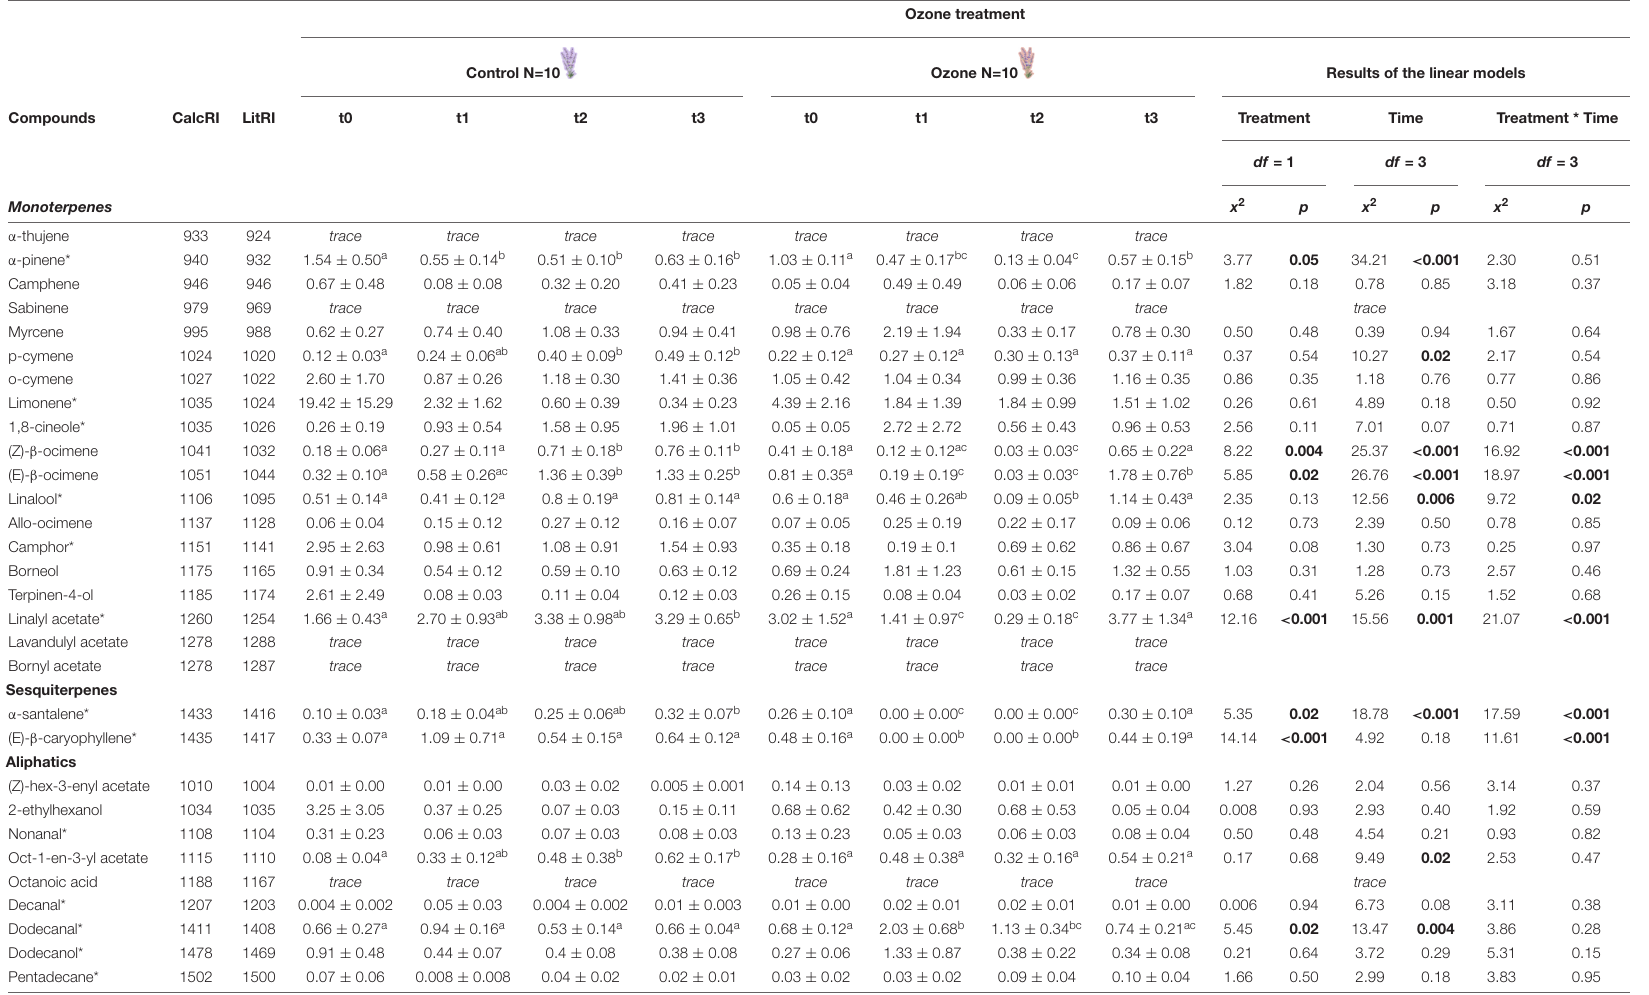
TABLE 1 | Effects of the O 3 treatment and time on the estimated concentrations of the different VOCs detected in experiment 1. For each modality of the different factors, see Figure 1